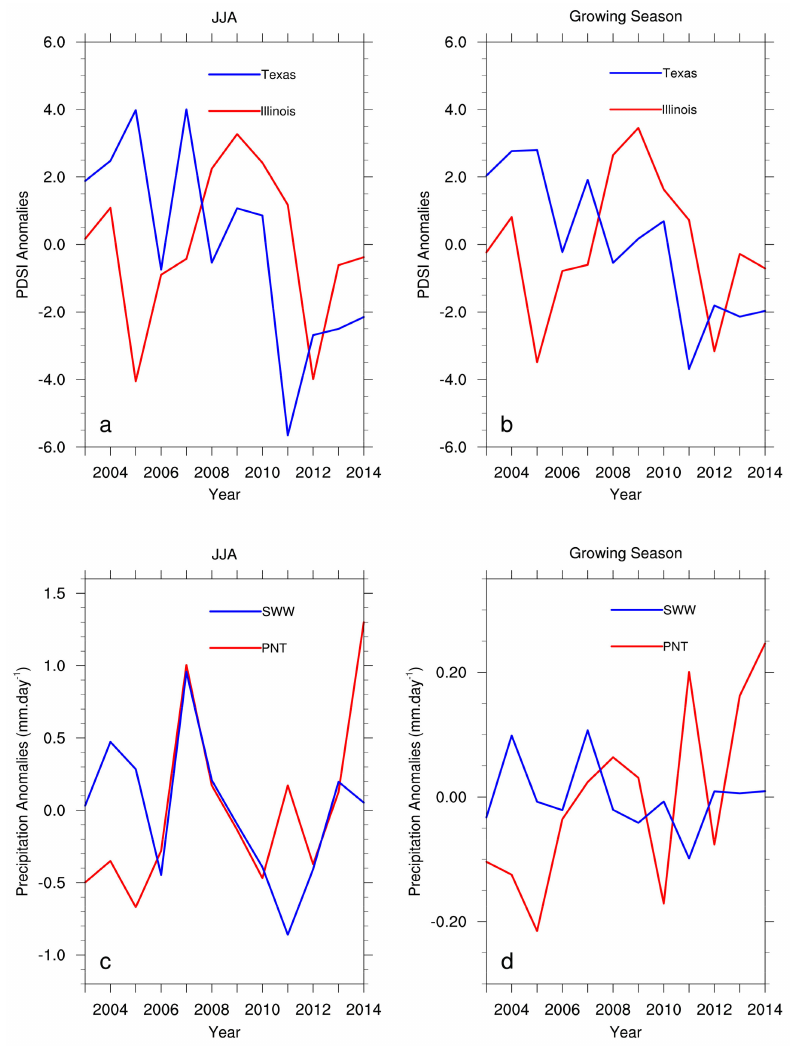
Figure 3. Interannual variations of PDSI and precipitation (mm/day) anomalies for the period of 2003–2014 from Texas (blue) and Illinois (red): ( a ) PDSI anomalies in JJA, ( b ) PDSI anomalies during the growing season, ( c ) precipitation anomalies in JJA, ( d ) precipitation anomalies during the growing season. Note that the precipitation measurements are obtained from Pontiac, Illinois (PNT) and Sweetwater, Texas